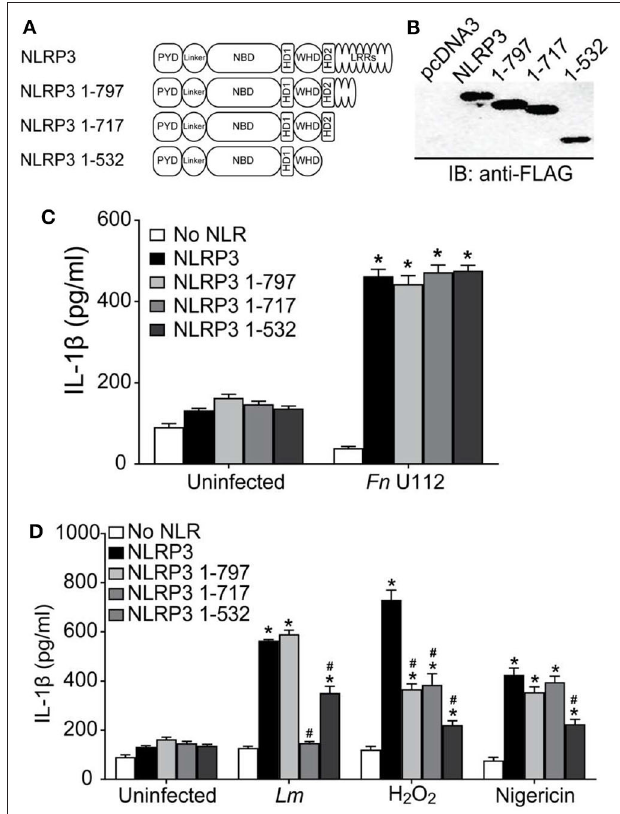
FIGURE 2 | NLRP3 activation by diverse agonists requires distinct protein structures. (A) Schematic representation of C-terminal LRR domain truncation mutants. (B) Representative western blot of FLAG-tagged NLRP3 and its C-terminal LRR truncation mutants from HEK293T cell lysate. 10 µ g total protein was loaded in each well. EV-Empty vector. (C,D) HEK293T cells expressing ASC, pro-Caspase-1, pro-IL-1 β , and NLRP3, or the indicated LRR domain truncation mutants. (C) At 4-h post-transfection, cells were infected with Fn U112 (MOI 100). (D) 18–20h post-transfection, cells were infected with Listeria monocytogenes (Lm) (MOI 20; 6h) or treated with 100 µ M H 2 O 2 (1h) or 5 µ M nigericin (2h). IL-1 β in culture supernatant was measured by ELISA. Data represent means ± SEM for a minimum of three independent experiments. * p < 0.0001 for comparison with respective untreated controls; # p < 0.0001, two-way ANOVA followed by Tukey’s (*) and Sidak’s ( # ) multiple comparison